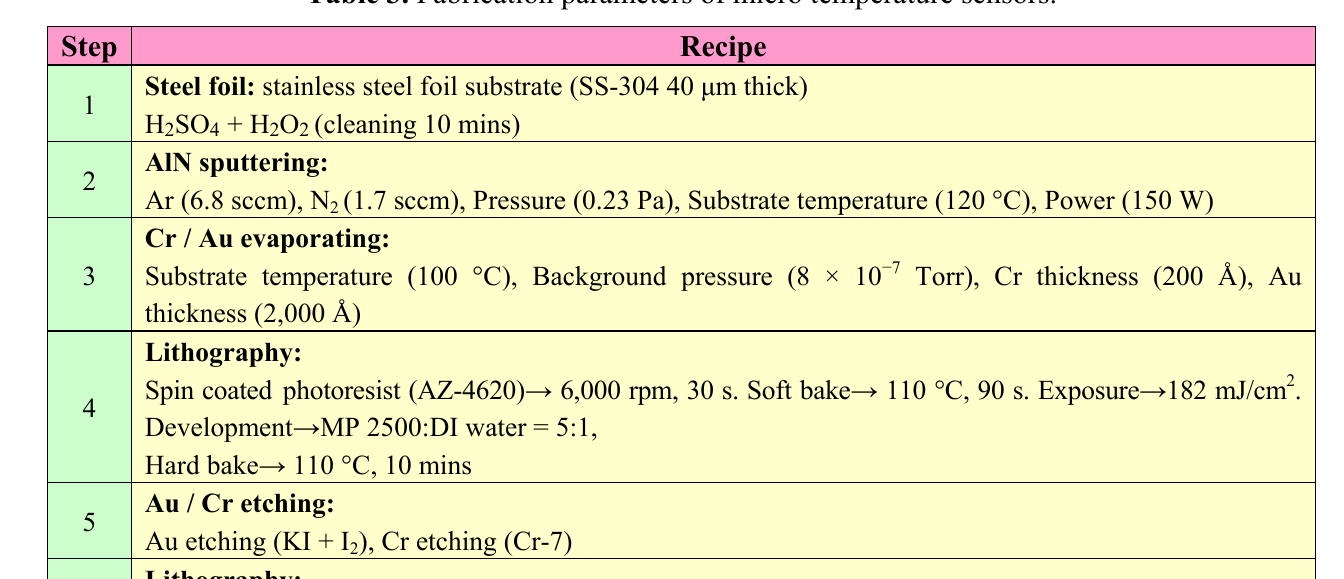
Table 3. Fabrication parameters of micro temperature